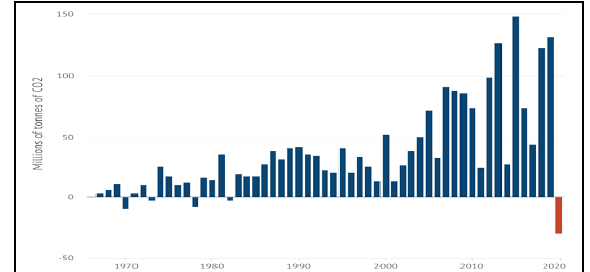
Figure 4. Annual CO 30MtCO e (1.4 %) in the financial year 2